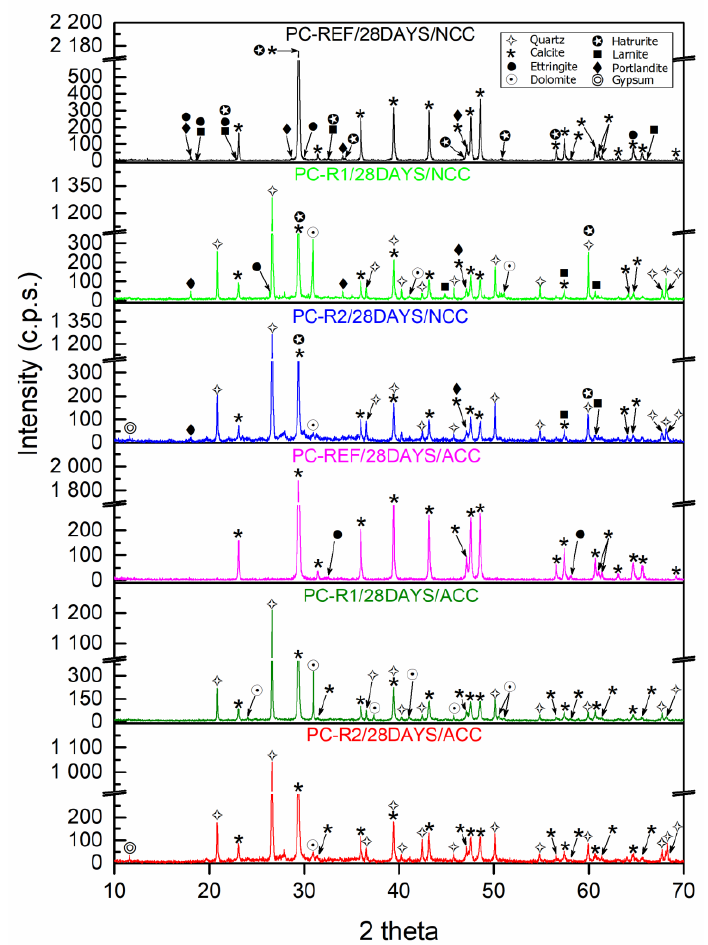
Figure 6. X-ray diffraction patterns of hardened concrete at 28 days of curing in NCC and ACC environment.